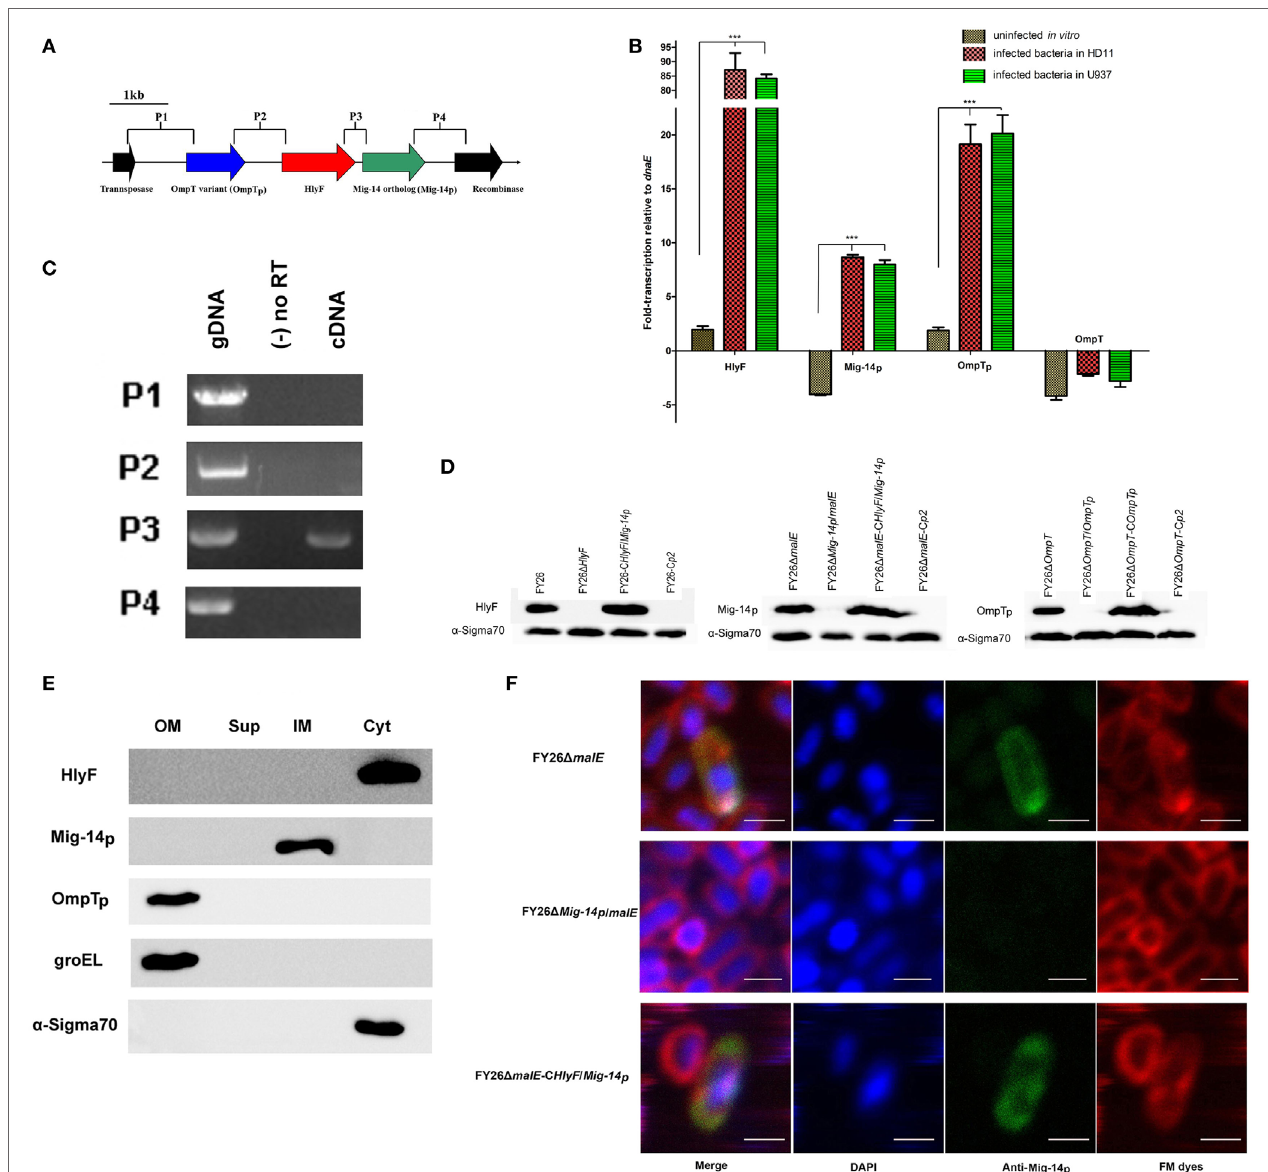
FigUre 1 | Molecular characterization and subcellular localization of HlyF, Mig-14p, and OmpTp encoded by ColV plasmids in extraintestinal pathogenic Escherichia coli (ExPEC) strain FY26. (a) Chimeric feature and genetic context of hlyF , Mig-14p , and OmpTp located in ColV plasmids. The arrows and its direction indicated the gene size and transcription direction for these genes. (B) The transcription levels of hlyF , Mig-14p , OmpTp , and ompT (negative control) in strain FY26 under different conditions by quantitative real-time RT-PCR (qRT-PCR). The transcriptional differences of these genes during FY26 infecting HD11 and U937 cells were determined relative to that in routine culture condition (uninfected in vitro ). The qRT-PCR data (relative to housekeeping gene dnaE ) from three independent experiments were used to identify the transcriptional differences (fold change), and statistically significant differences were determined using one-way ANOVA analysis (*** P < 0.01). (c) The co-transcription test for intergenic regions of hlyF , Mig-14p , OmpTp , and adjacent genes by PCR. Total RNA of FY26 was reversely transcribed to cDNA (PCR amplification templates). The negative control was the non-reverse transcriptional RNA. (D) Western blot analysis for the expression of HlyF, Mig-14p, and OmpTp in wild-type FY26, the mutants, and corresponding complemented strains. The immunoblotting assays were conducted with polyclonal anti-serums corresponding to fusion proteins (GST:HlyF, MBP:Mig-14p, and OmpTp), and detecting α -Sigma 70 expression acted as a reference. (e) Western blot analysis for subcellular localization of HlyF, Mig-14p, and OmpTp in wild-type FY26. Four FY26 subcellular components (OM, outer membrane proteins; Sup, concentrated culture supernatant; IM, inner membrane proteins; Cyt, cytoplasmic component) were separated and used to immunoblotting assays. The outer membrane protein groEL and cytoplasmic protein α -Sigma70 acted as the positive control. (F) Immunofluorescent detection of Mig-14p protein in ExPEC. FY26 Δ malE , FY26 Δ Mig-14p / malE , and FY26 Δ malE -C HlyF / Mig-14p for immunofluorescence detecting were fixed and probed with anti-MBP:Mig-14p serum and then labeled with fluorescent secondary antibodies conjugated to FITC. DAPI was used to label bacteria nucleic acid, and plasma membrane was stained by FM dyes. Scale bars = 1 μ